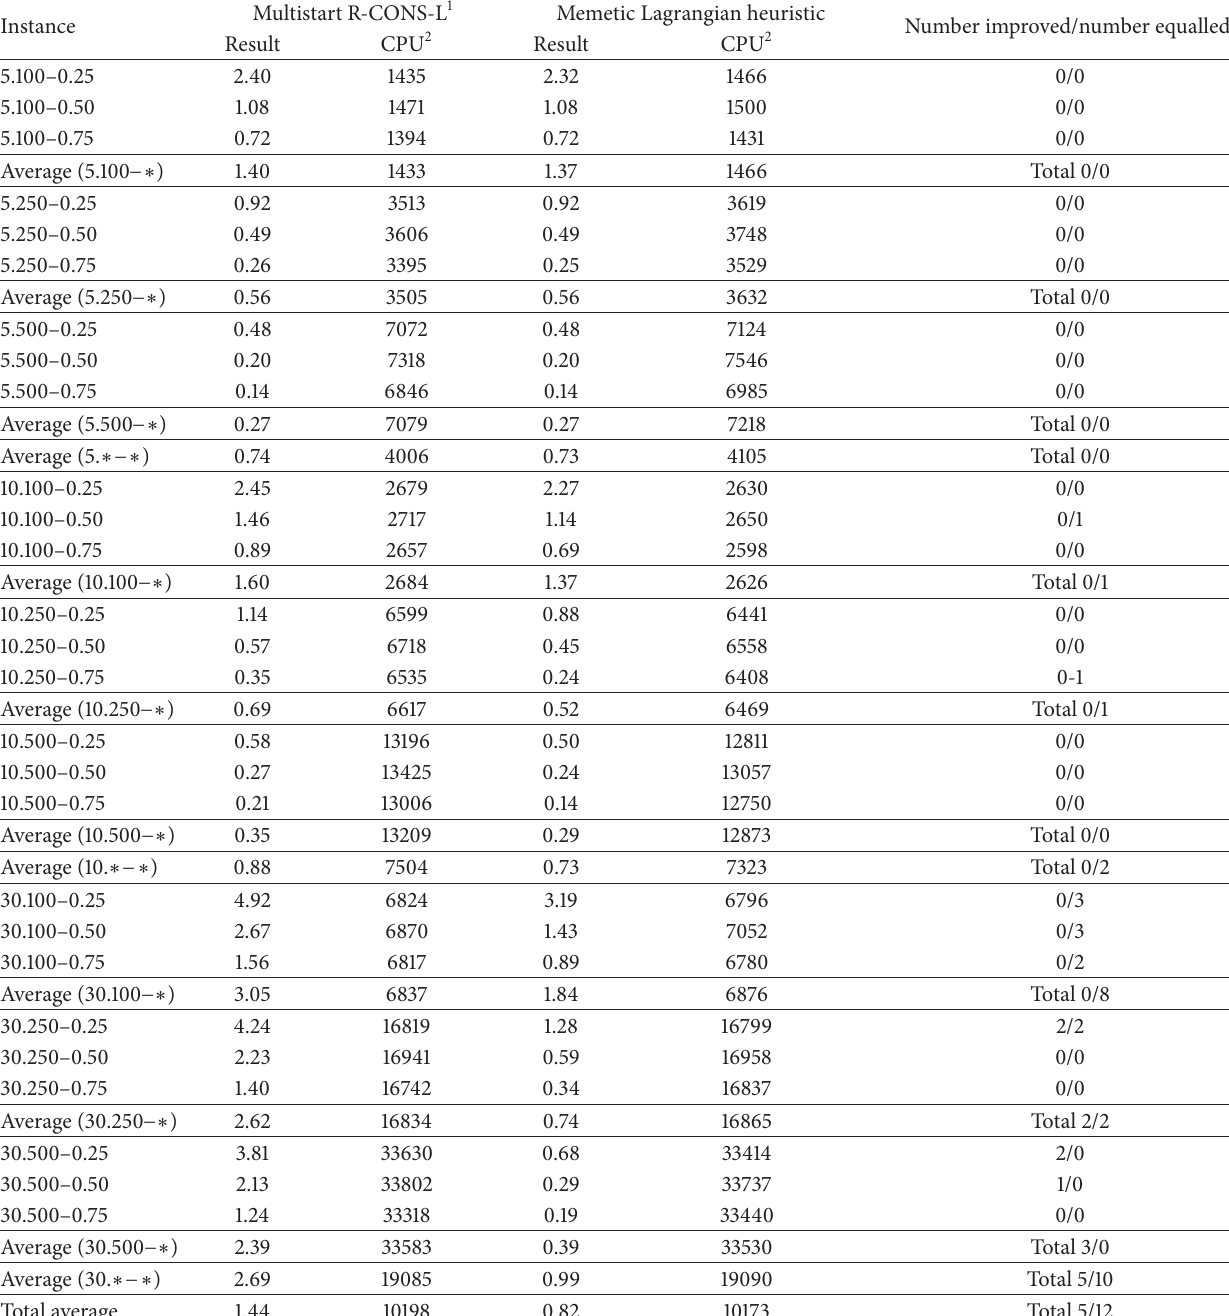
Table 2: Results of memetic Lagrangian heuristic on benchmark